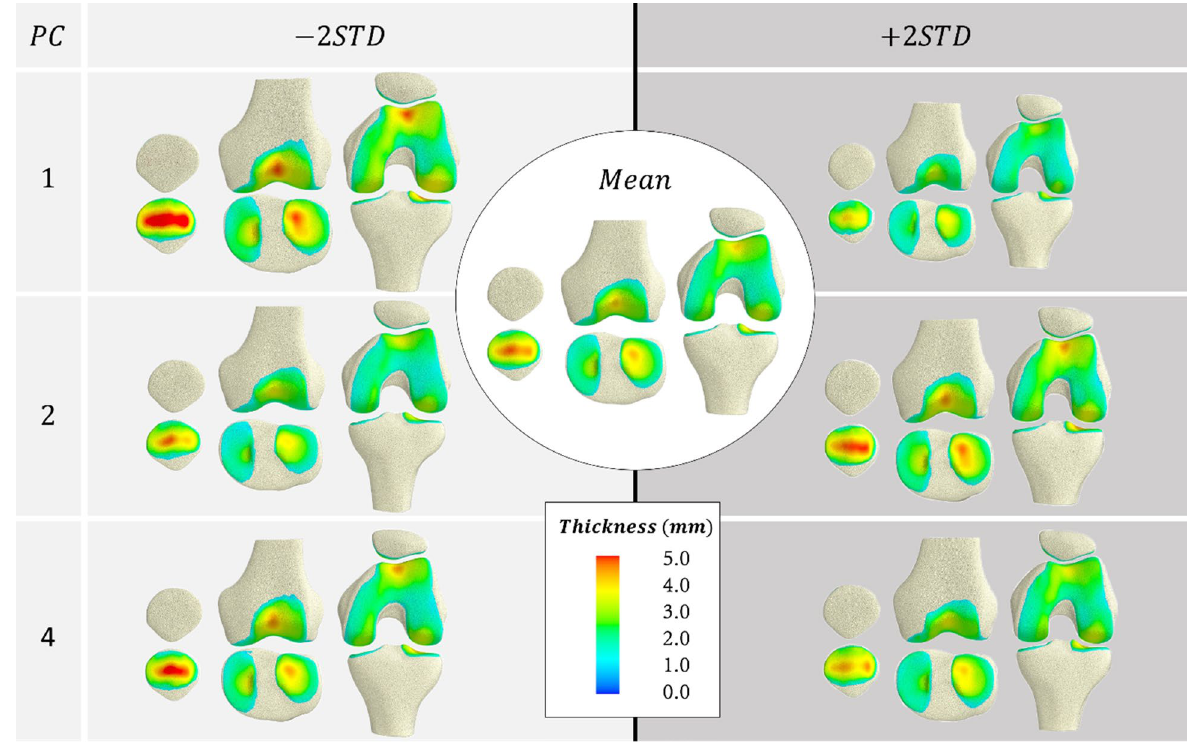
Figure 3. Coupled variations in bone shape and cartilage thickness of the SSFM showing principal components that were influenced by sex and height (PC1 and PC2), or sex (PC4).